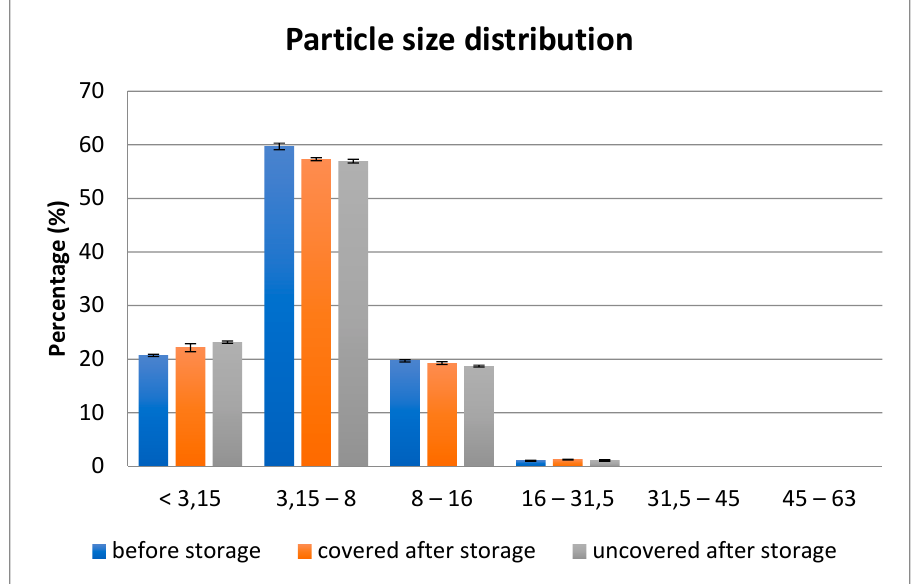
Figure 4. Particle size distribution of the chips before and after storage.